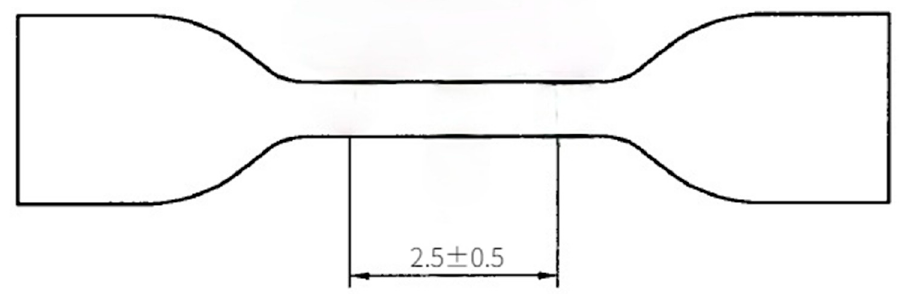
Figure 2. Dumbbell type specimen.